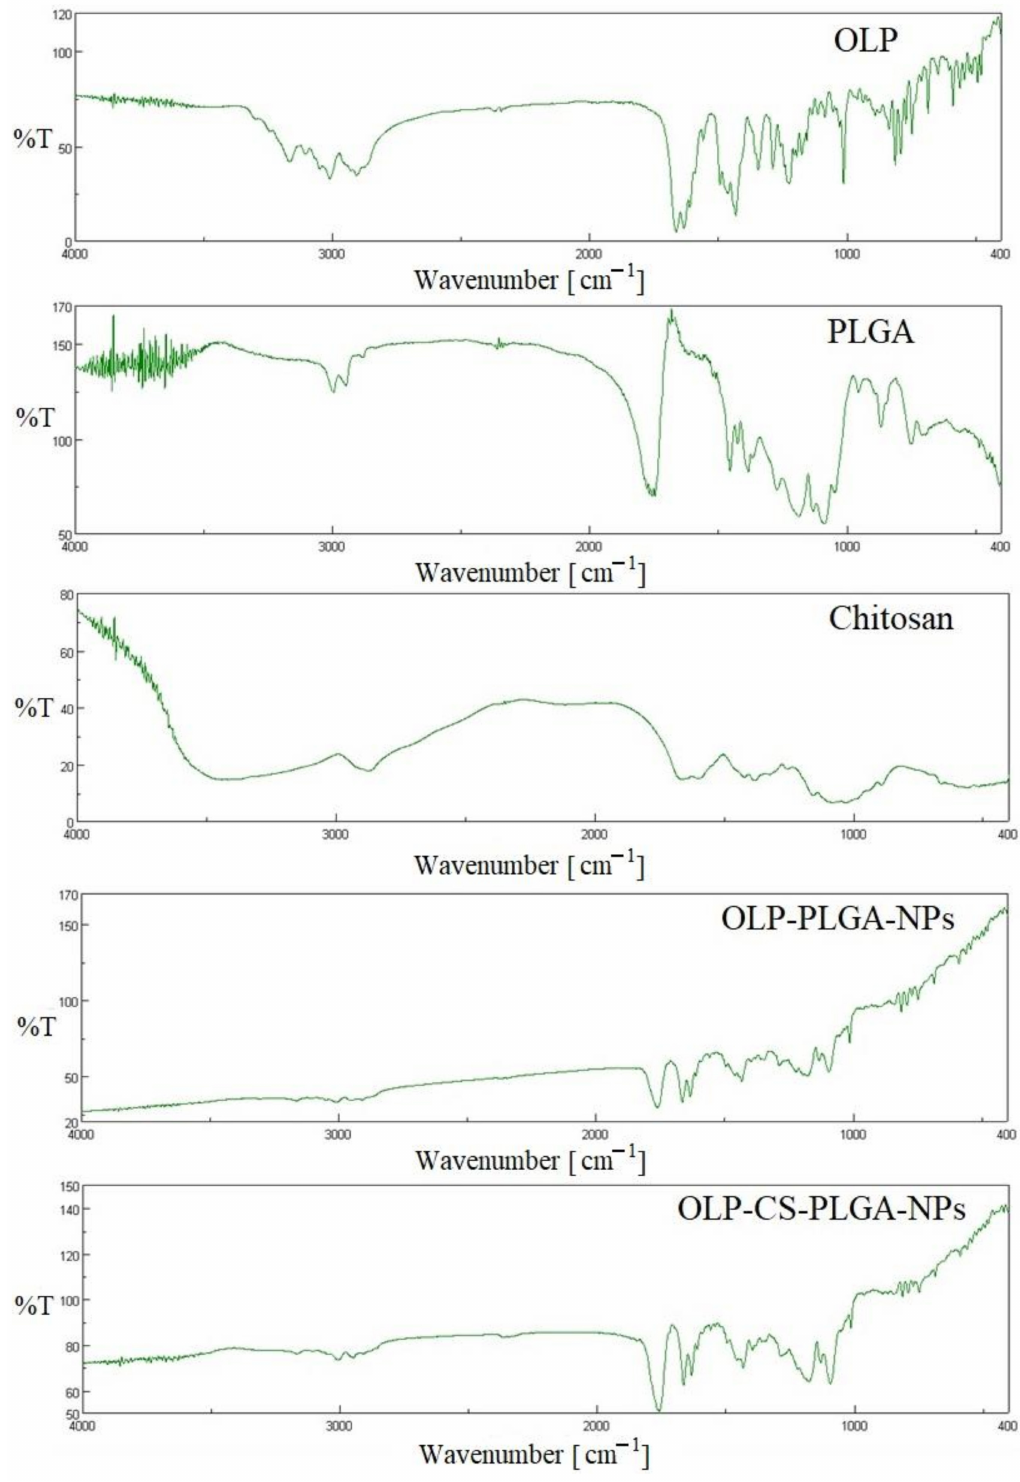
Figure 3. Comparative FTIR spectra of pure OLP and their developed